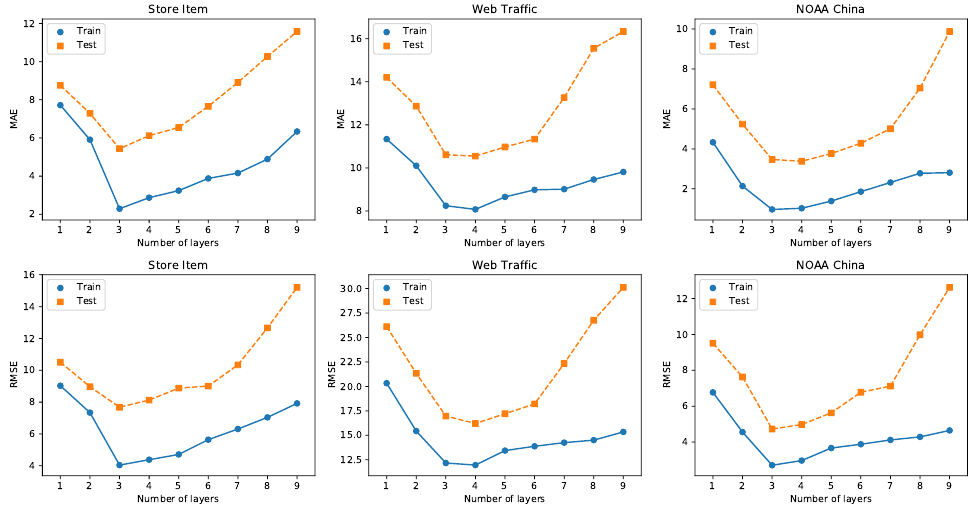
Figure 7. The influence of Graph Convolutional Network (GCN) depth on prediction